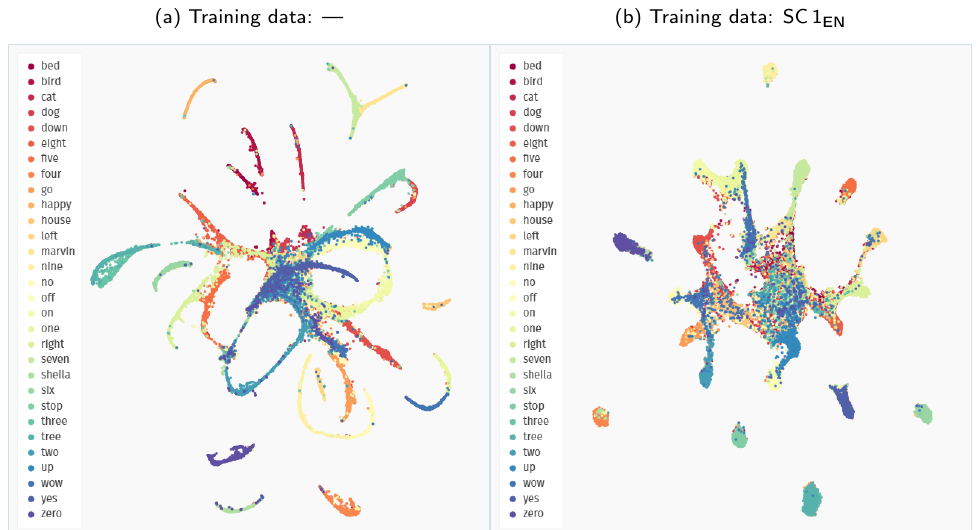
Figure 7. Comparison of the UMAP visualisations of the Speech Commands training examples (SC1 EN ) processed through the Google speech embedder: ( a ) embeddings generated with a pre- trained model without fine-tuning; ( b ) embeddings generated with a pre-trained model fine-tuned on the Speech Commands